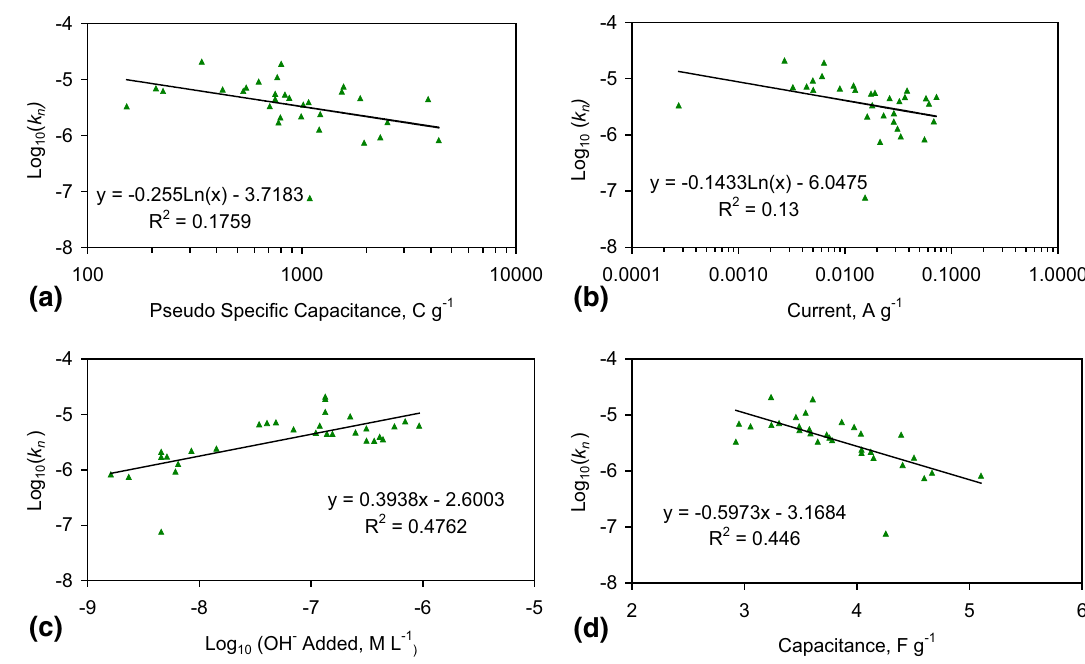
− added versus k k n . b Current versus n . c OH n